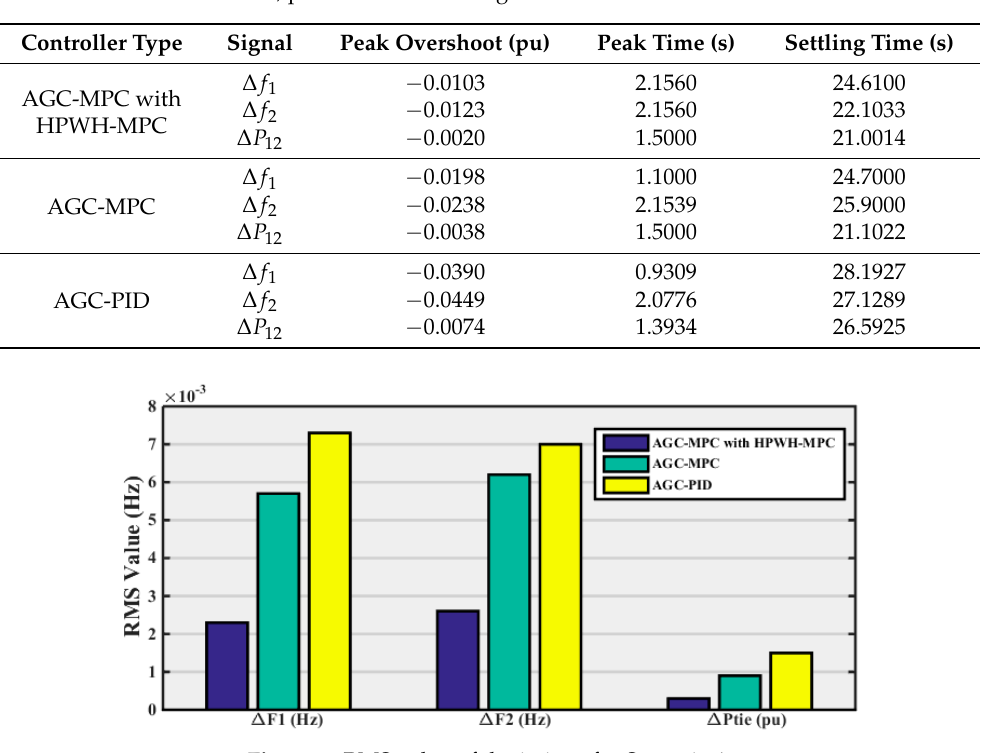
Table 2. Peak overshoot, peak time and settling time for the controllers in the first scenario.